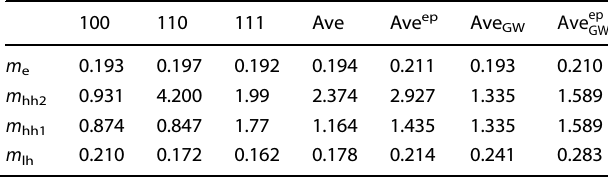
Table 1. Effective masses of zb-GaN DFT effective masses in electron mass units for zinc-blende GaN from PBE-SOC along the Γ − X (100), Γ − K (110), and Γ − L (111) directions, their averages with (Ave ep ) and without (Ave) coupling with longitudinal phonons together with averaged GW results of Ref. 31 (Ave GW ) and the same with electron- phonon corrections ( Ave ep ). GW